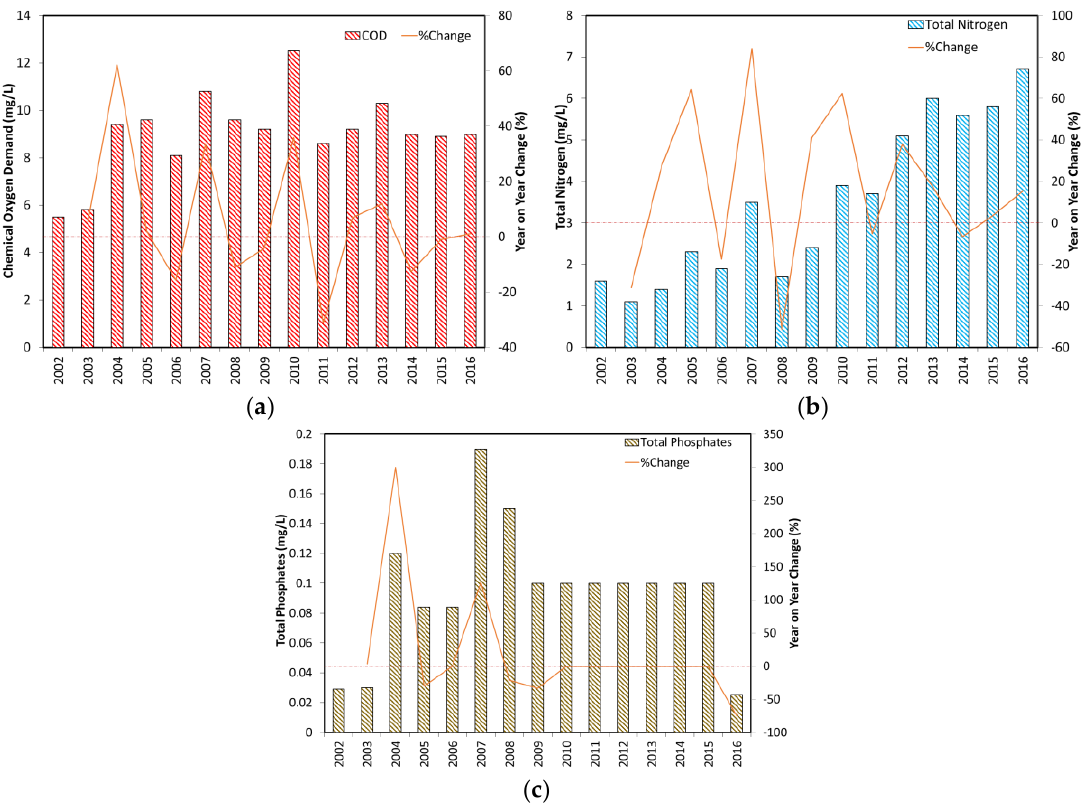
Figure 5. The annual wastewater pollutants at KIX during 2002–2016 and the year-on-year change (%): ( a ) Chemical Oxygen Demand (COD), ( b ) nitrogen, and ( c ) phosphates. Source: data derived from [12,13].